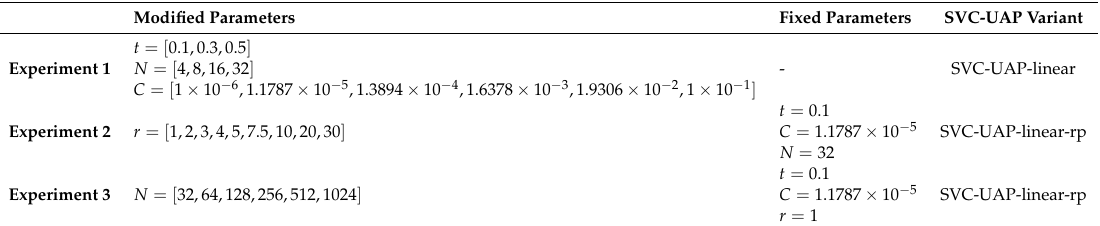
Table 2. This table contains a brief description of each of the experiments that have been conducted in the ablation